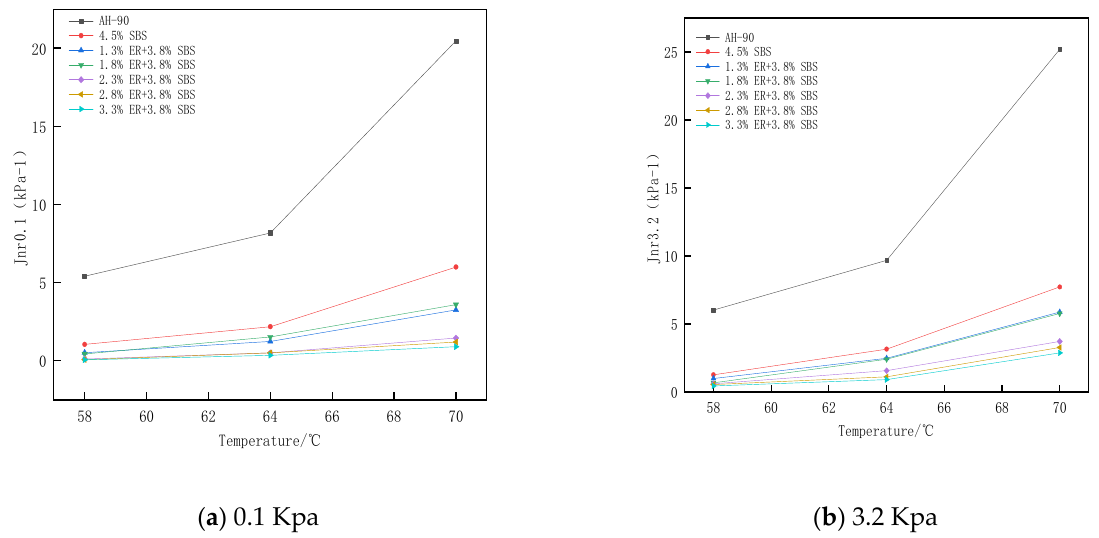
Figure 15. Changes in the irrecoverable creep flexibility of each bitumen with temperature under different stresses.